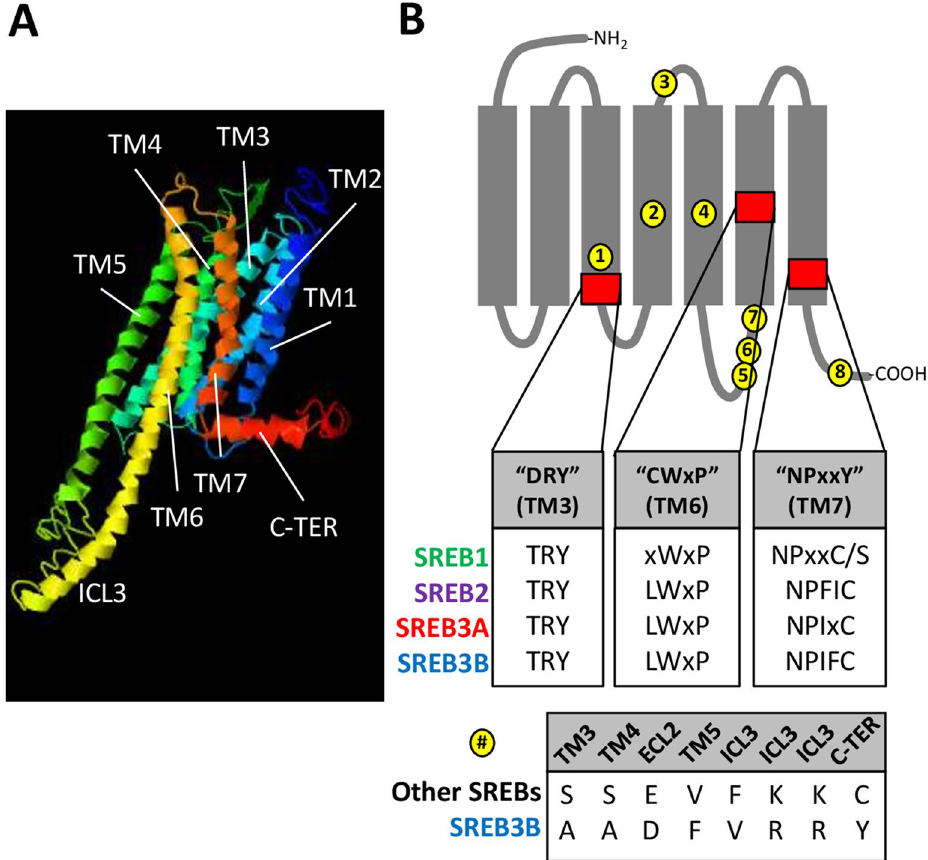
Figure 4. SREB amino acid sequence comparisons. ( A ) Three dimensional model of Dichotomyctere nigroviridis SREB1 was made using I-TASSER (C-score = −0.76), to show highly conserved seven transmembrane domains (TM), elongated third intracellular loop (ICL3), and C-terminal region with the eighth α-helix (C-TER). Other models for D. nigroviridis SREB2-3B and Danio rerio SREB1-3A also exhibited similar characteristics (not shown). ( B ) Identification of highly conserved amino acid positions unique to SREB3B (yellow circles) and SREB deviations from canonical GPCR functional motifs (red squares with first inset). The gray diagram indicates GPCR structure with transmembrane α-helical domains (rectangles, TM1-TM7) and extracellular (top gray lines, ECL) and intracellular (bottom gray lines, ICL) domains. The DRY, CWxP, and NPxxY canonical motifs refer to Nygaard and colleagues 55 . Each amino acid position identified with a letter refers to > 94% conservation across that SREB isoform in the dataset (positions labeled “x” are not highly conserved). The position labeled “C/S” in SREB1 refers to a highly conserved cysteine (C) in many less-derived species but is replaced with serine (S) in more-derived fishes (Neoteleosti). The bottom inset shows the eight residues (yellow) that characterize SREB3B (bottom row) and are divergent but highly conserved across all other isoforms (top